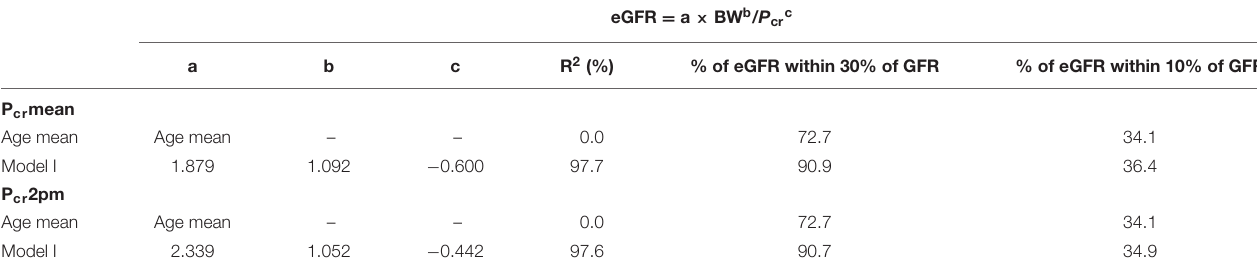
TABLE 3 | Properties (adjusted R 2 and the relative accuracy) of eGFR equations derived from coefficients of different regression